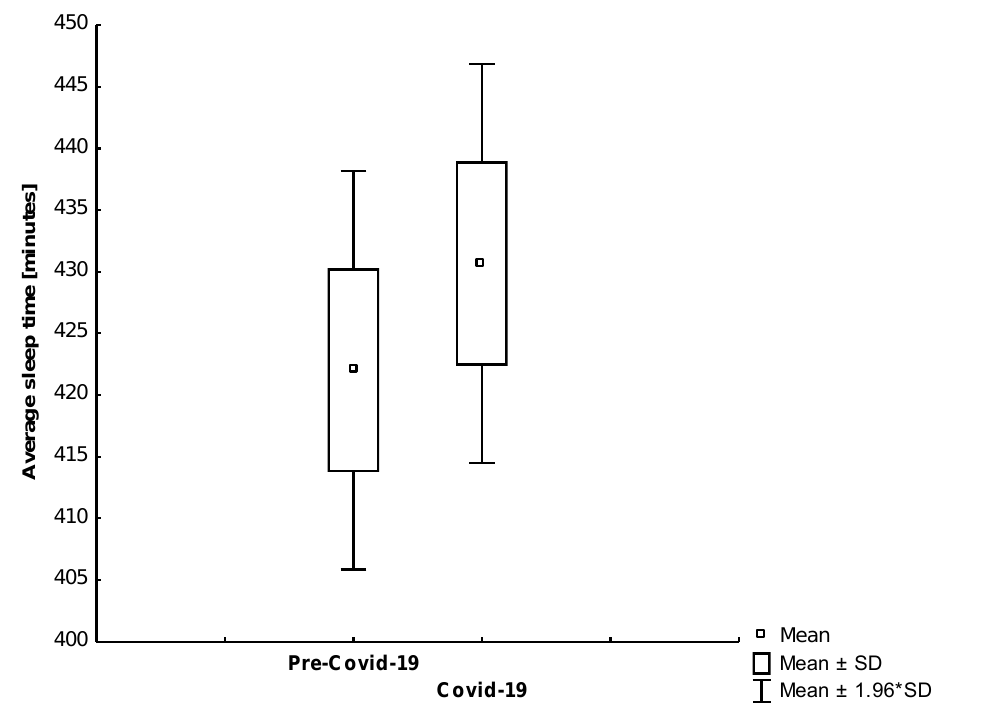
Figure 9. The comparison of the average sleep time in the analyzed periods among younger partici- pants ( p = 0.441).